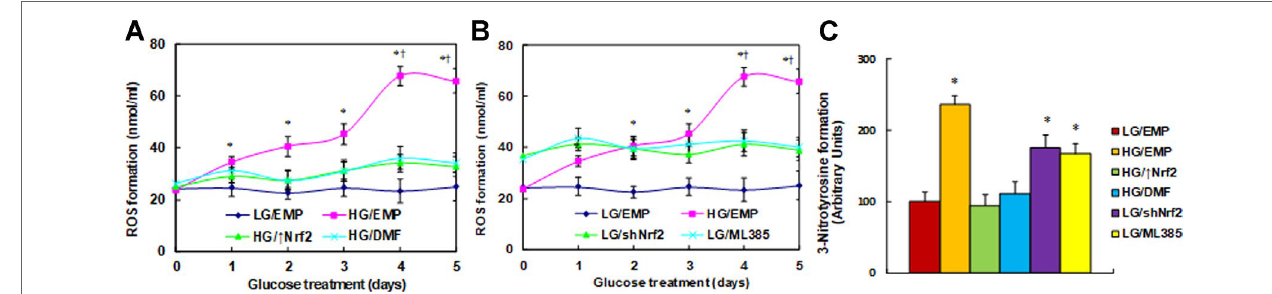
FIGURE 1 | Nrf2 activation restores, while Nrf2 suppression mimics, hyperglycemia-induced ROS generation. (A) Rat macrophages were infected by an empty vector (EMP), Nrf2 lentivirus (Nrf2 ↑ ), or Nrf2 knockdown lentivirus (shNrf2) in the presence of either 5 µM Nrf2 activator DMF or 5 µM Nrf2 inhibitor ML385 (with 0.1% DMSO as vehicle) and then incubated in either low glucose (5 mM) or high glucose (25 mM glucose) continuously for 5 days in the presence of 1% FBS, and the cells were harvested on each day for analysis. (A) ROS generation in the presence of Nrf2 overexpression (Nrf2 ↑ ) or Nrf2 activator (DMF), n = 5. * P < 0.05, vs day